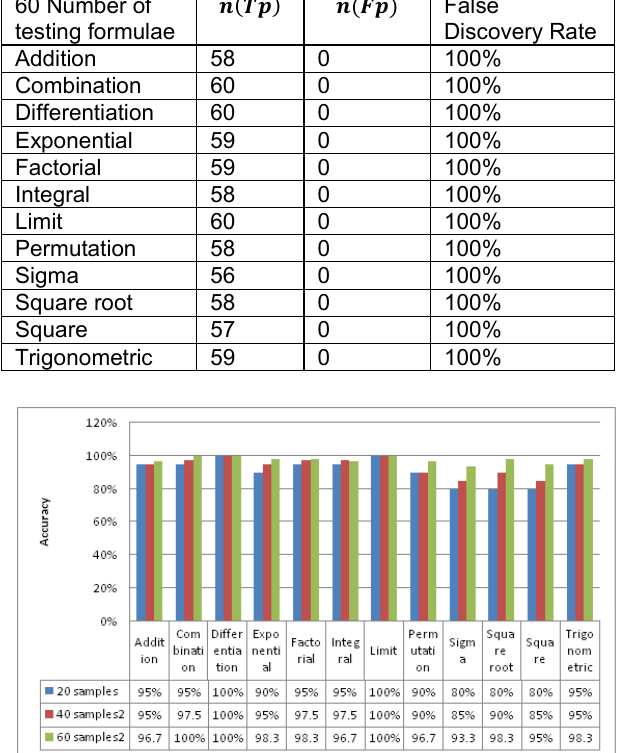
Figure 2. Overall Accuracy Measure with Tensorflow from a